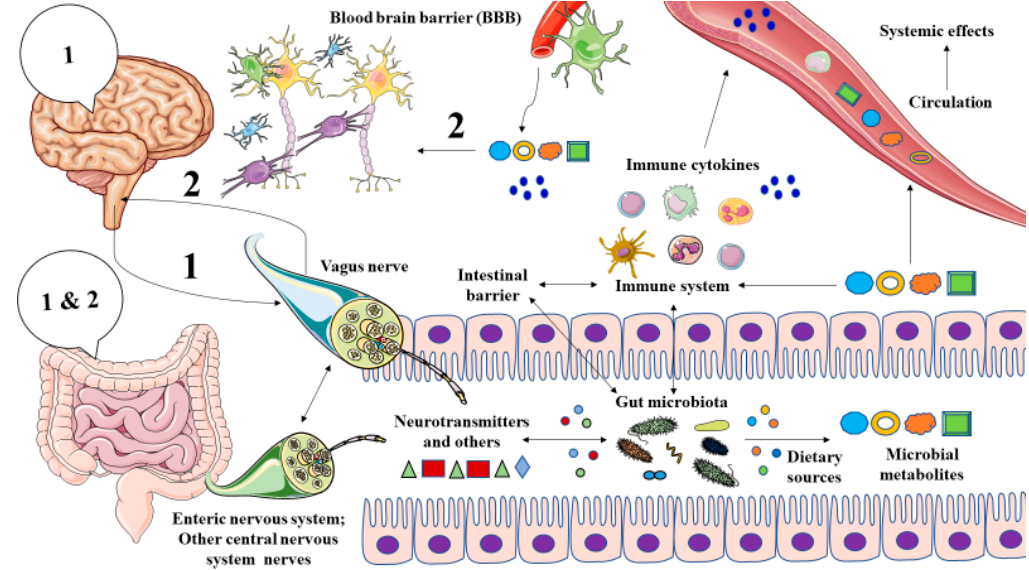
Figure 1. A general picture of the Microbiota-Gut-Brain Axis. As represented, there is bidirectional communication between the brain and the gut through different mechanisms. The vagus nerve